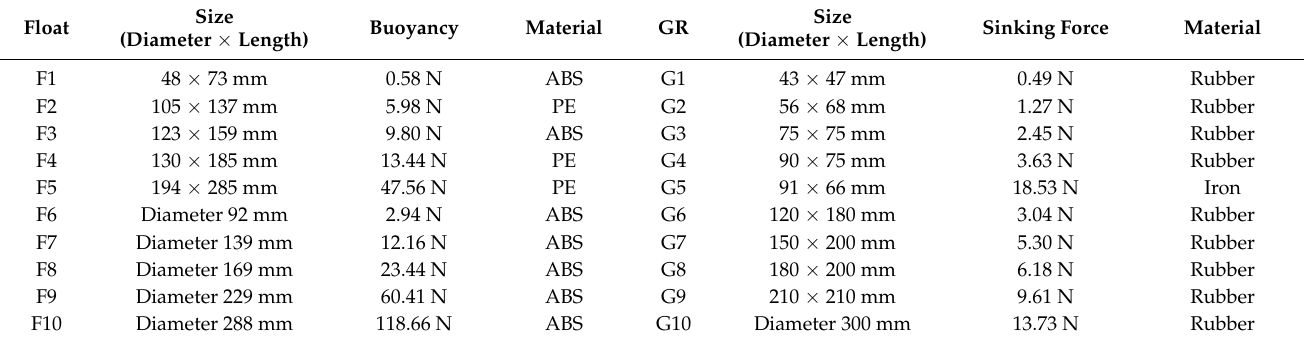
Table 1. Floats and ground gears (GR) which were measured in the tank and towing experiments.